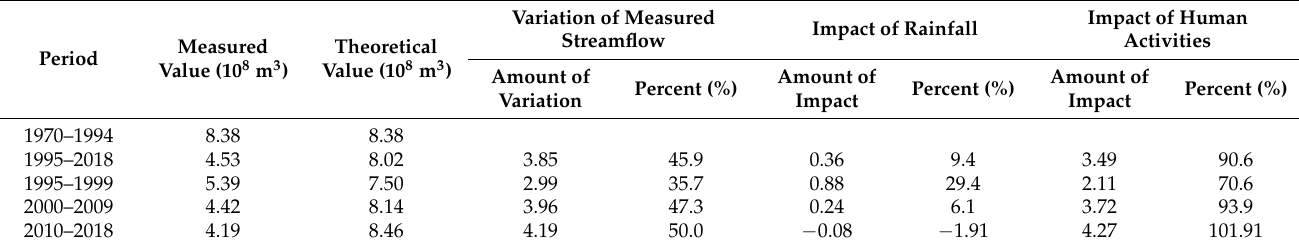
Table 7. Contribution rates of precipitation and human activities to different periods before and after abrupt point year in the Beiluo River Basin.